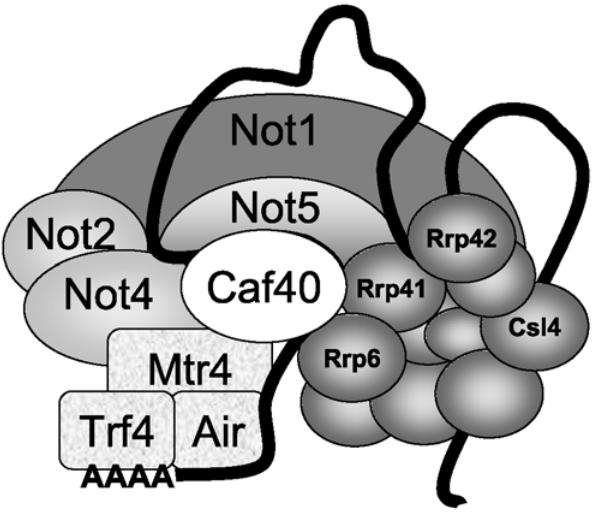
Figure 9. Model for the connections between the Ccr4-Not, TRAMP and exosome complexes. A large(s) structure(s) containing Ccr4-Not, TRAMP, the nuclear exosome and RNA, that may function to coordinate activity of TRAMP and the nuclear exosome, is suggested by our work. Not1, the scaffold of the Ccr4-Not complex is associated with Not5, Not2, Not4 and Caf40 (shown), as well as Caf1, Ccr4, Caf130, and Not3 (not shown). Mtr4 is a subunit of TRAMP that co-immunoprecip- itates with Caf40 and Not4, and is co-purified with Tap-tagged Caf40 together with the Ccr4-Not complex. Its association with Not4 (and other subunits of the Ccr4-Not complex) increases in the absence of Caf40. In contrast, Caf40 is required for the interaction between Mtr4 and Rrp6, suggesting that maybe Caf40 contributes to release Mtr4 (and TRAMP) from the Ccr4-Not complex to the nuclear exosome. Rrp41 co-purifies with Tap-tagged Not5, and Rrp41, Rrp42 and Mtr4 co-purify with Not2-Taptag or Not4-Taptag when Caf40 is deleted, probably because the tagged proteins in association with the exosome and TRAMP become accessible to purification in this mutant. Finally, the nuclear exosome becomes more accessible to purification via Rrp41- Taptag when the integrity of the Ccr4-Not complex is compromised by deleting Caf40 or Not4, or when RNA is destroyed. Not5 co-purifies with Tap-tagged Csl4, and with Tap-tagged Rrp41 when it is more accessible to purification by RNA degradation or deletion of Caf40 or